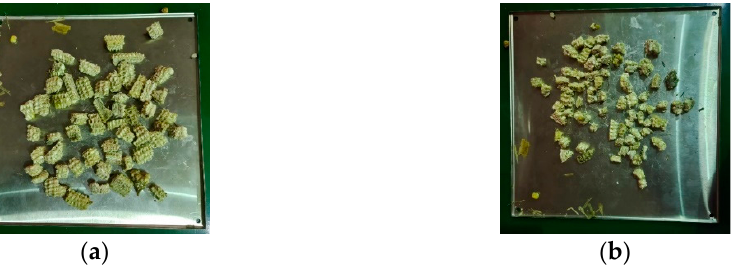
Figure 1. Broken corncobs: ( a ) Large-sized broken corncobs; ( b ) Small-sized broken corncobs.